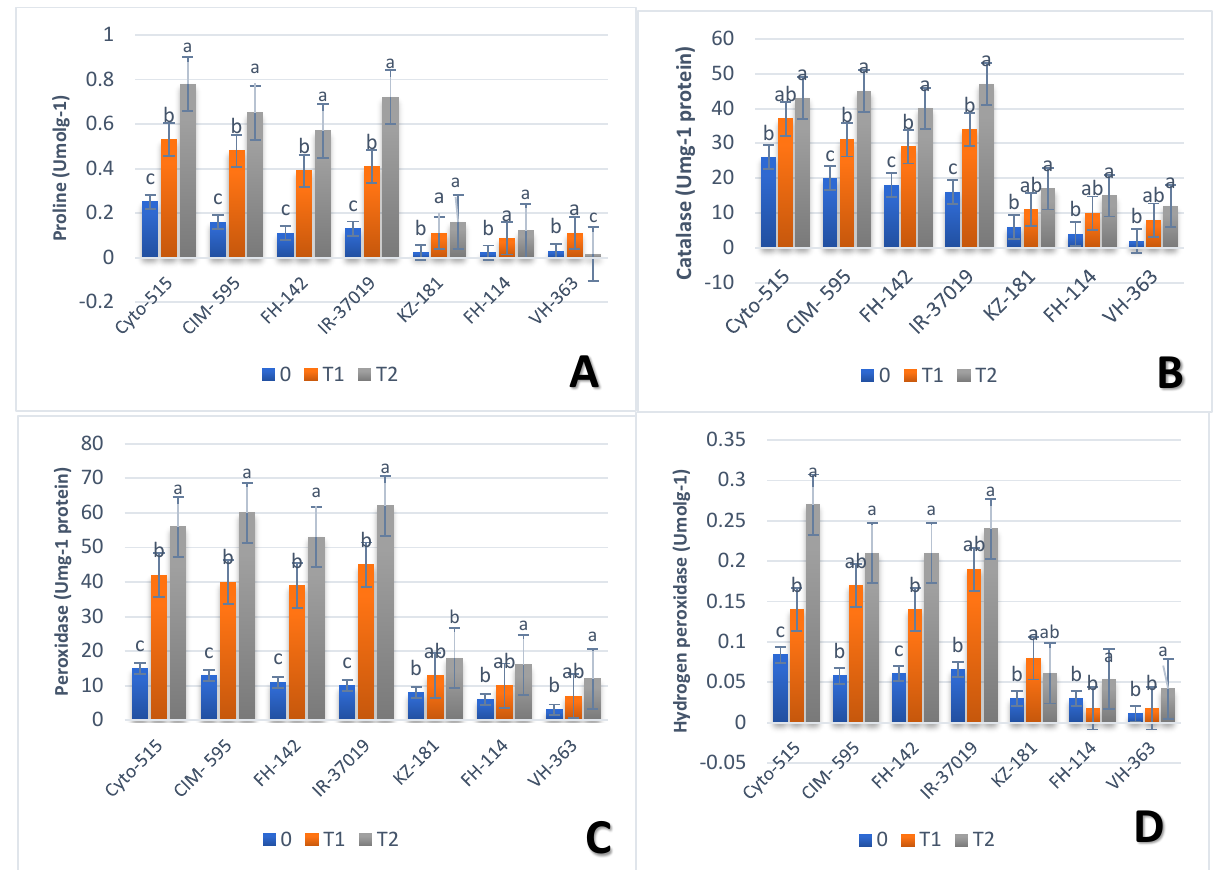
Figure 5. Effect of drought stress on biochemical traits of drought-tolerant and susceptible genotypes of cotton ( A ) Proline content, ( B ) Catalase, ( C ) Peroxidase ( D ) Hydrogen Peroxidase. Treatments: T0 = Control, T1 = 75% water stress, T2 = 50% water stress, and bars with the different lettering showed significant differences while the same lettering bars showed non-significant differences between these genotypes.